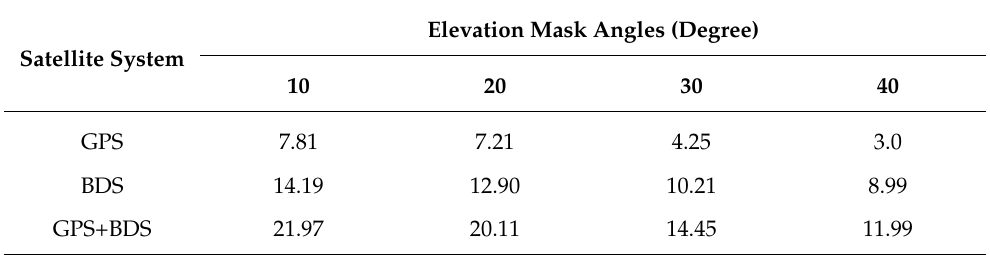
Table 2. The average number of GNSS visible satellites at different elevation mask